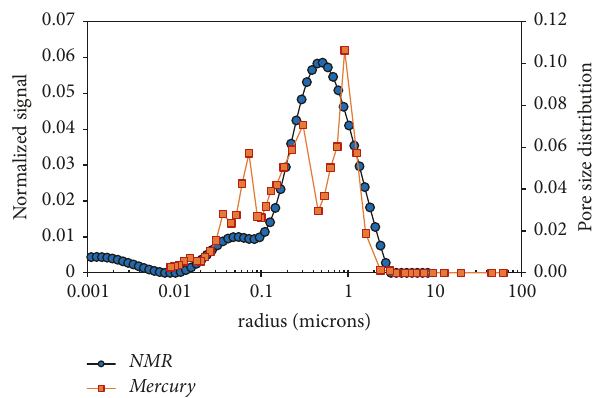
Figure 3: MIP and NMR methods of porosity using a PES/C5.